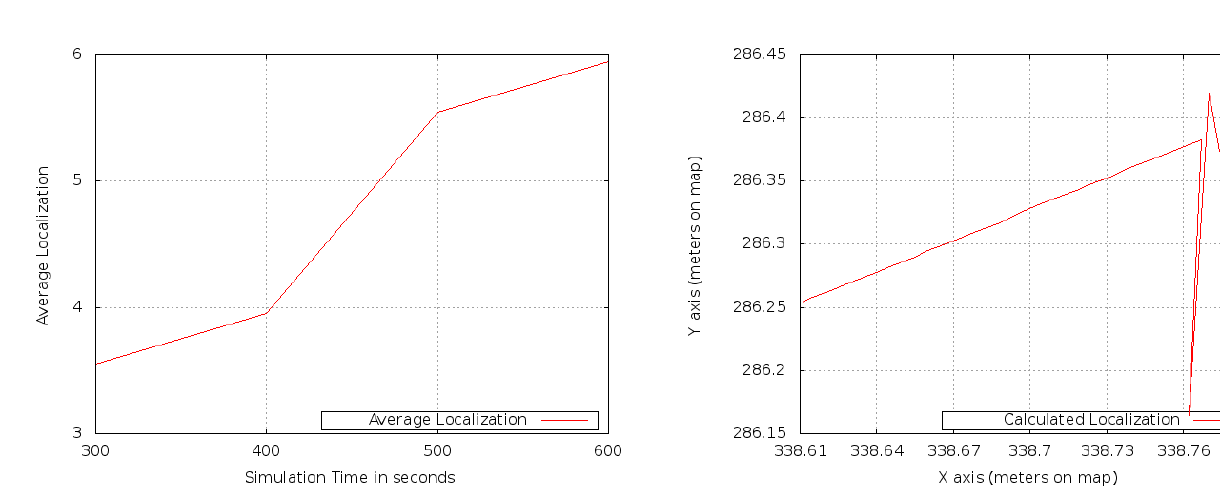
Figure 8. Variation in localization with simulation time